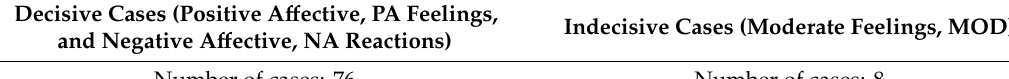
Table 4. Result (performance) from the CCS communication and engagement agent ( Agent 2 ) to be shared with Agent 1 to communicate with the user using its corresponding human languages in Table 1. Decisive Cases (Positive A ff ective, PA Feelings,